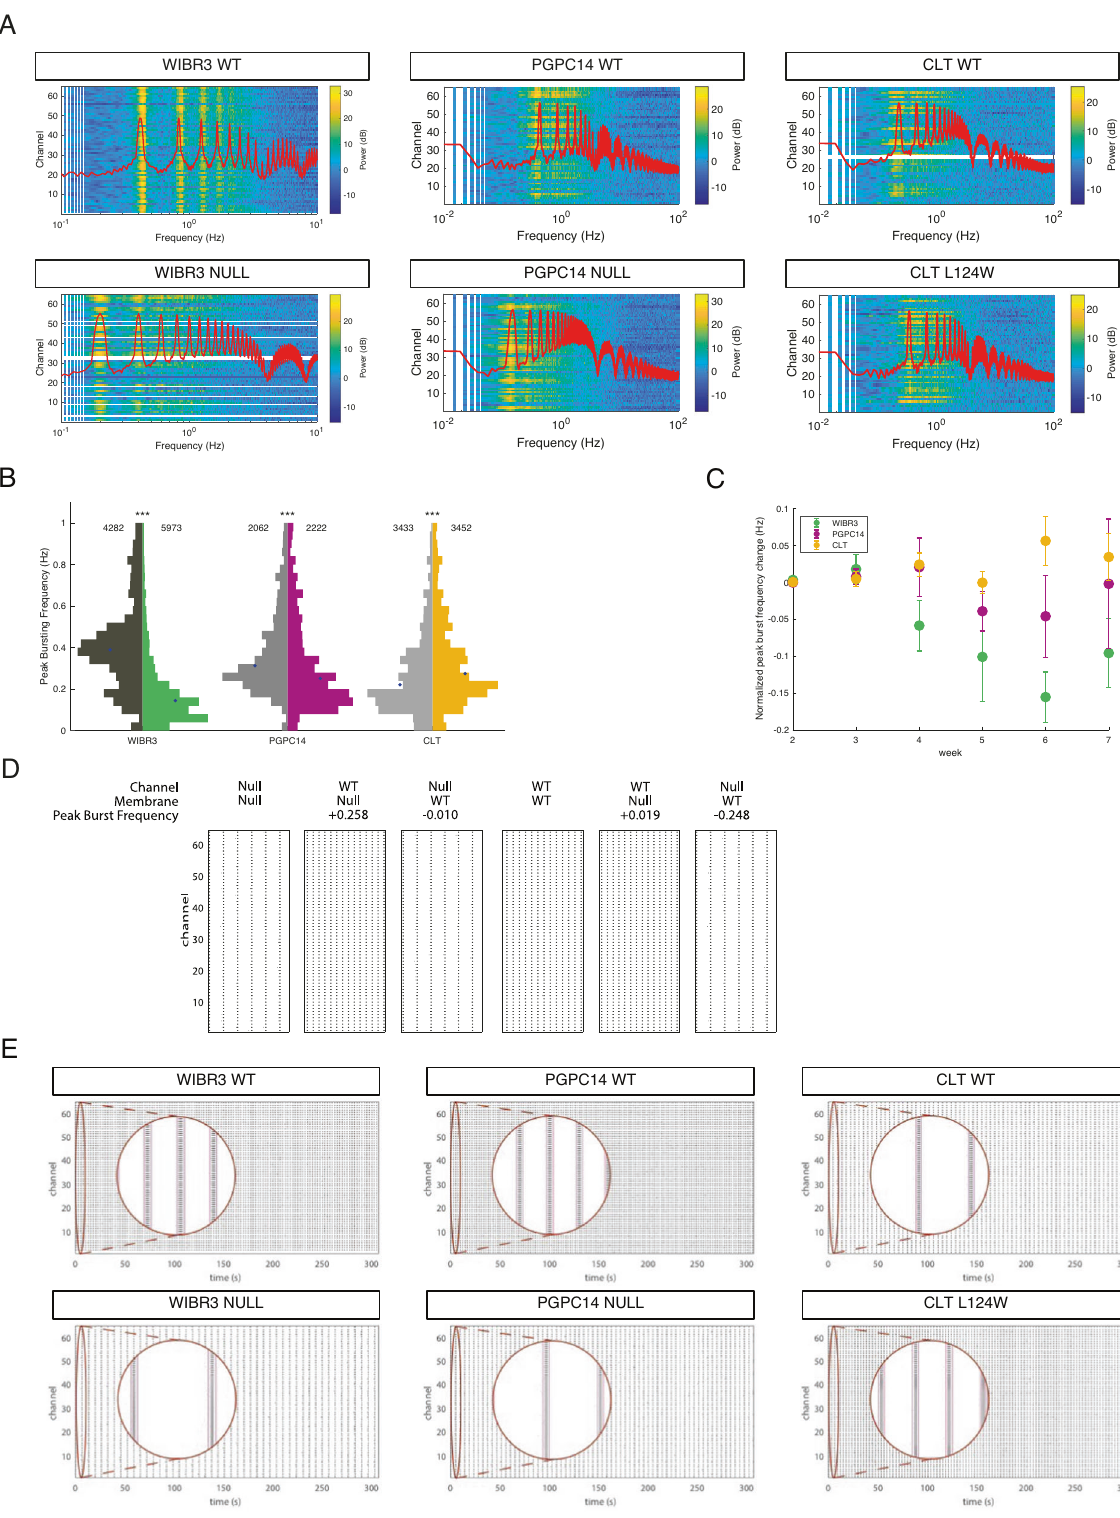
difference between the direction of peak burst frequency change in the CLT L124W compared to MECP2 null neurons. Changes in burst frequency can have at least two different origins, one is changes in the intrinsic properties of individual neurons, and the second is changes in network synaptic